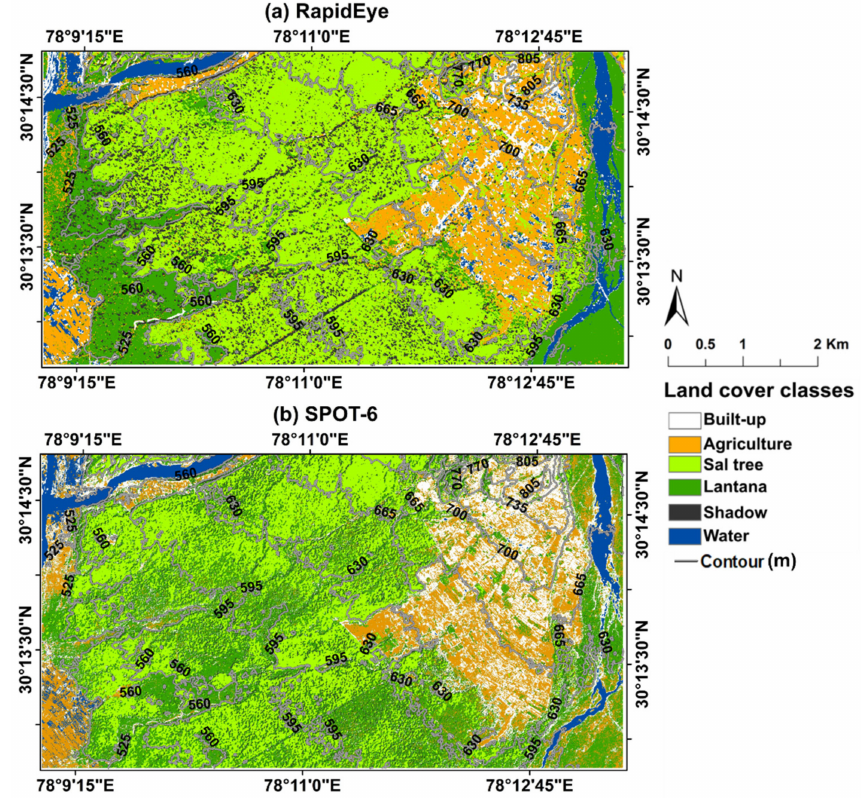
Figure 4. RF classification of ( a ) RapidEye and ( b ) SPOT-6 multispectral imageries for smaller